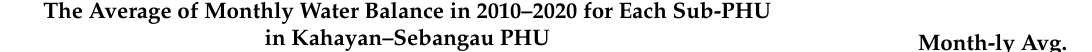
Table 2. Average values of monthly water balance calculations for the sub-PHUs (data source: TerraClimate using Google Earth Engine; processed by the